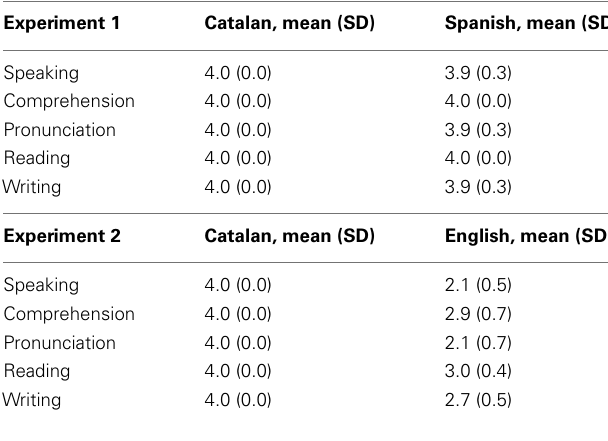
Table 1 | Language proficiency (mean and SD) of speaking, comprehension, writing, and reading abilities for each language, self-rated on a four-point scale (1 = poor, 2 = regular, 3 = good, 4 =